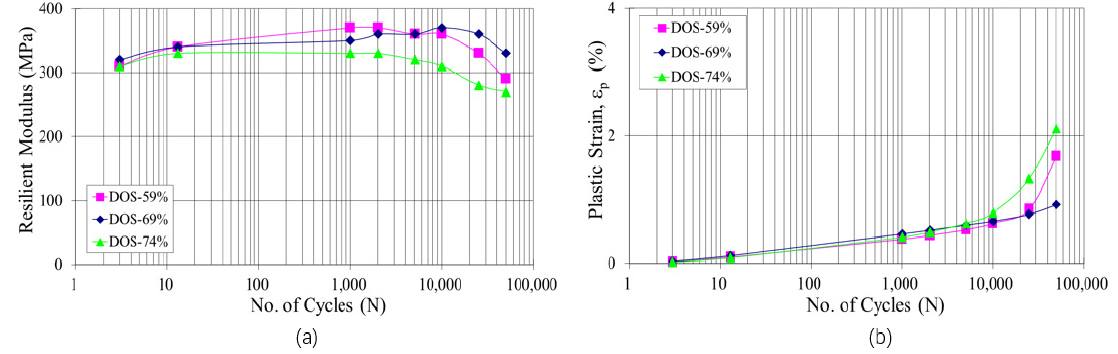
Figure 5. The relationship between the dynamic response and the number of cycles with an applied deviator stress of 625 kPa: ( a ) resilient modulus; ( b ) plastic strain.